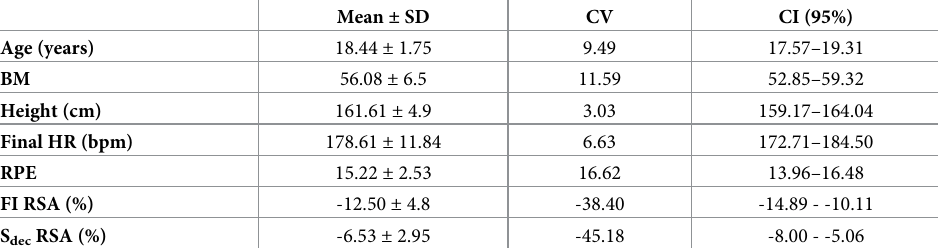
Table 1. Descriptive analysis of the sample and fatigue variables.